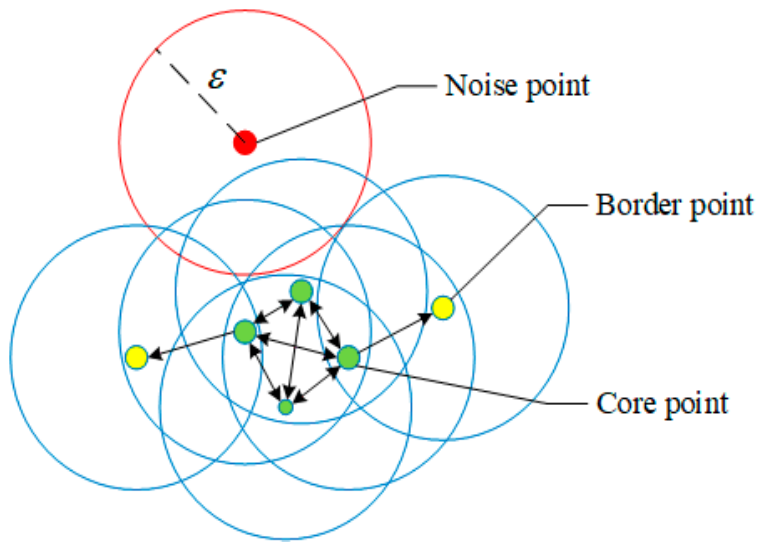
Figure 2. Schematic of the DBSCAN.